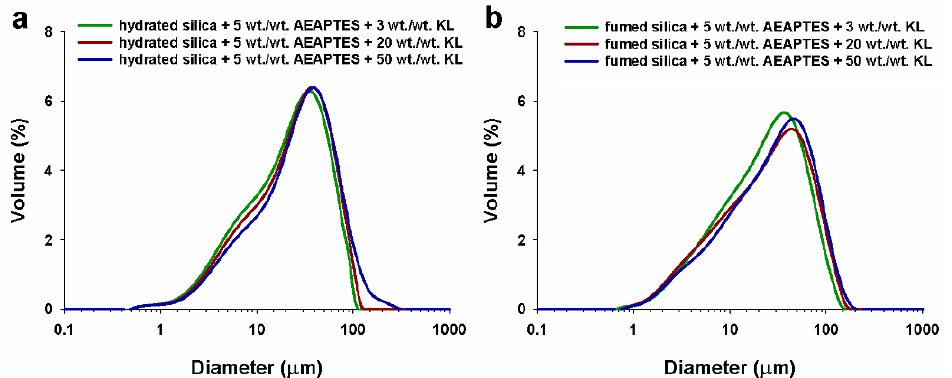
Figure 4. Particle size distributions (Mastersizer 2000) of silica/lignin hybrid materials obtained from hydrated silica (a) and fumed silica (b).